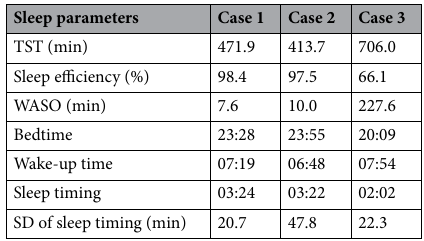
Table 2. Sleep parameters based on actigraphy of three representative cases. TST total sleep time, WASO wake after sleep onset, SD standard deviation.